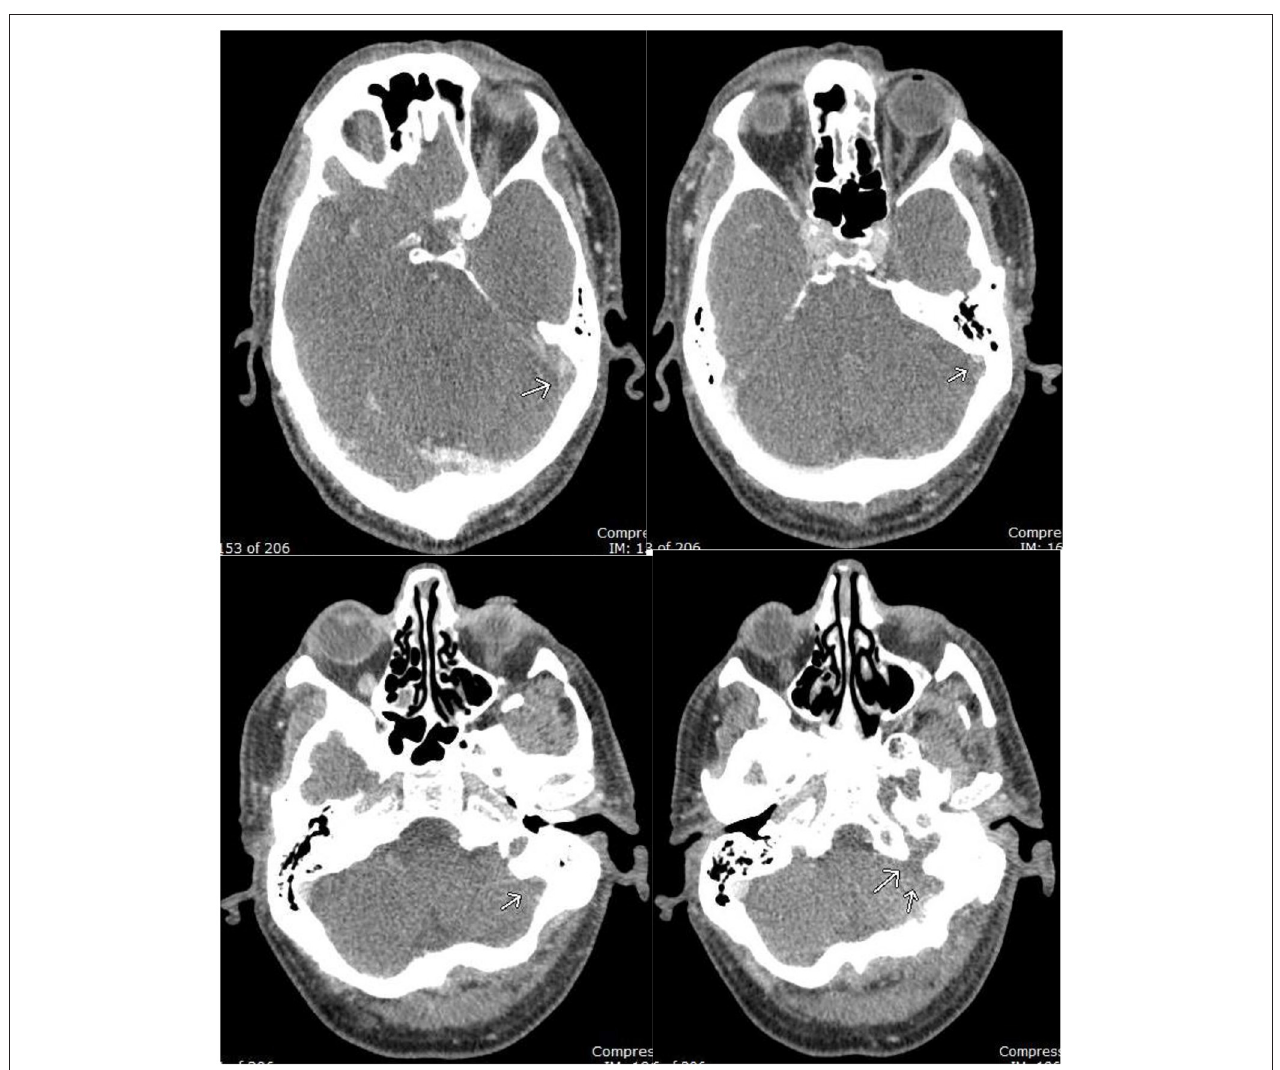
FIGURE 2 | CT Venogram: filling defect in the left distal transverse sinus, sigmoid sinus, and jugular bulb, compatible with occlusive dural venous sinus thrombosis.